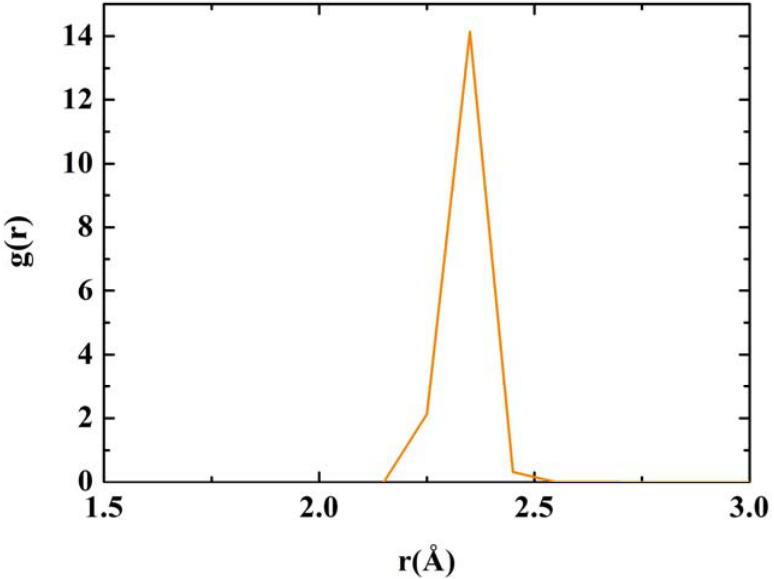
Figure 12. RDF for nanoporous silicon. Fine structure of the first peak of the Tersoff RDF. The prominent peak occurs at 2.35 Å, the crystalline interatomic bond length, a secondary one at 2.25 Å and two minor contributions at 2.45 Å and 2.55